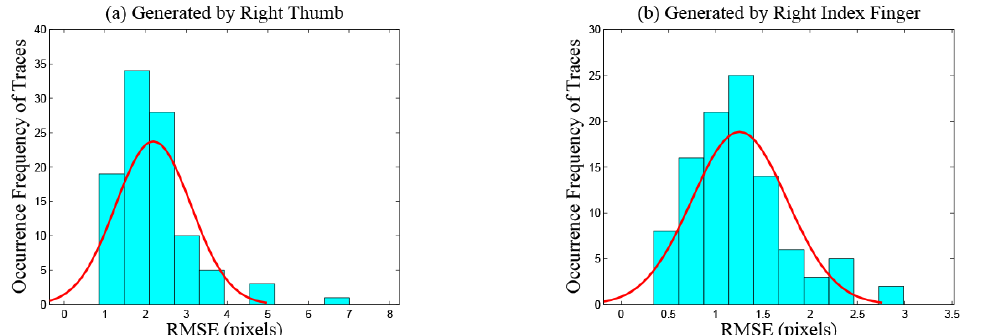
Figure 5. Root mean squared errors of 200 touchscreen traces.